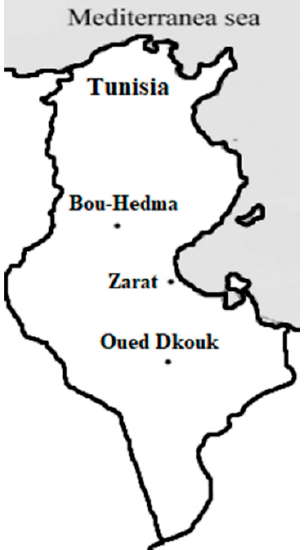
Figure 1. Location of the three conserved natural areas in the arid Mediterranean ecosystem of Tunisia.